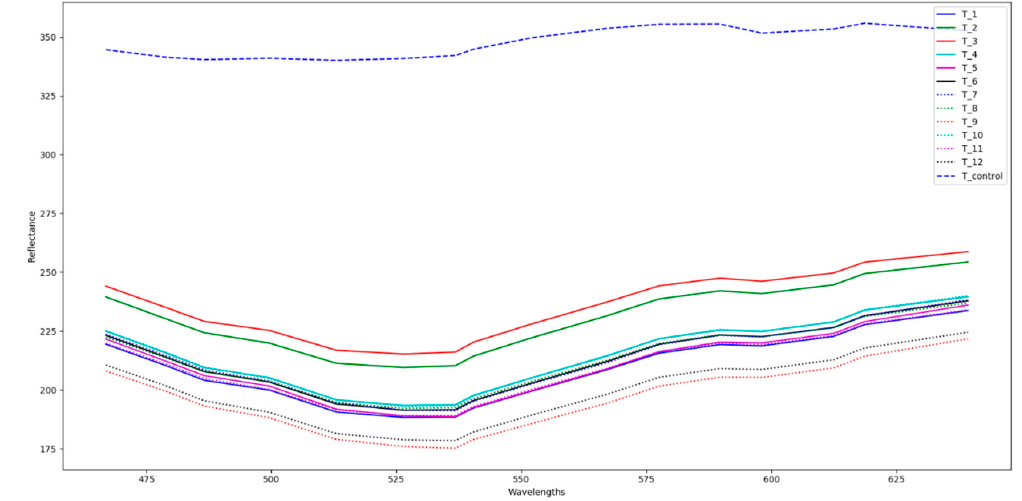
Figure 8. Average spectra for 12 processed trays and one control of mashed potato.